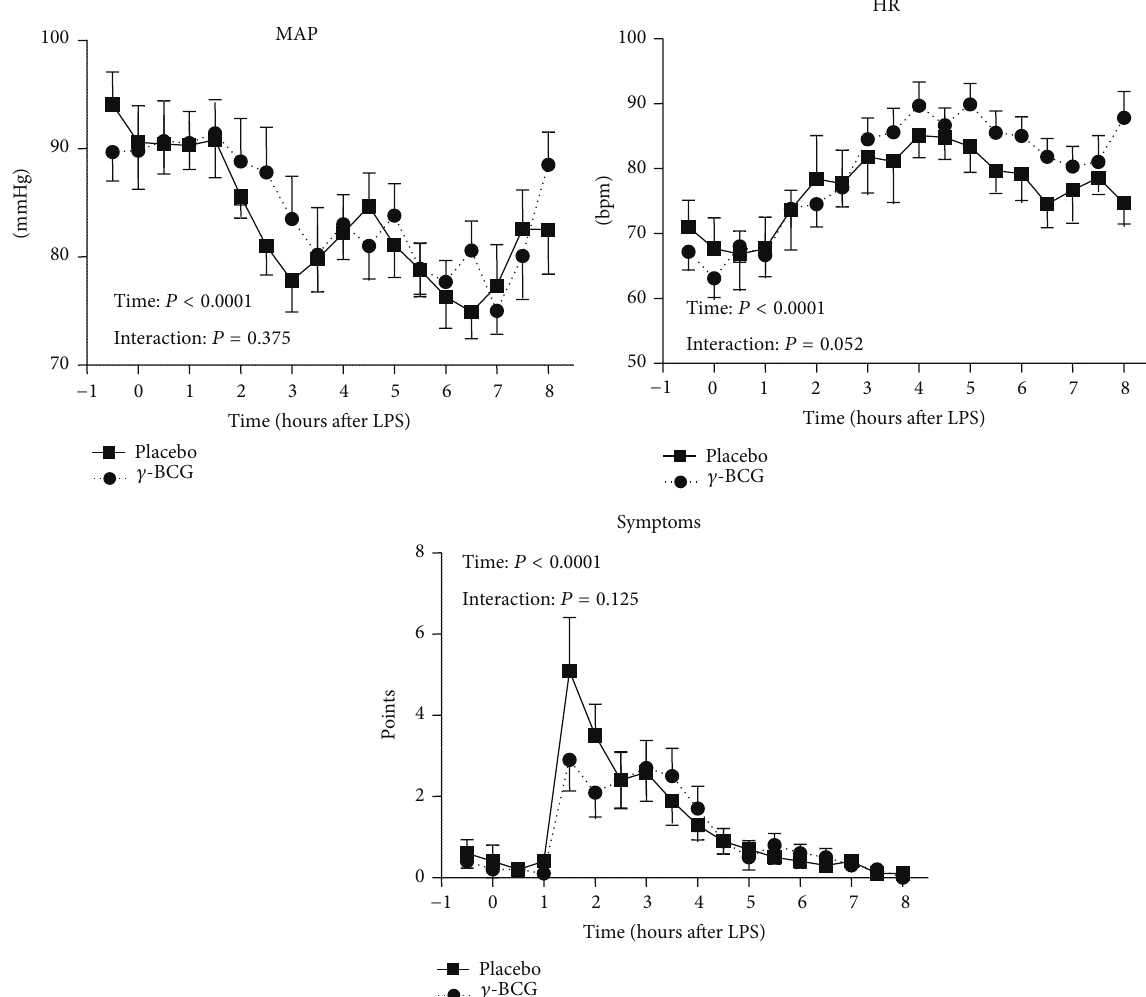
Figure 2: Blood pressure, heart rate, and symptoms during experimental endotoxemia in subjects vaccinated with gamma-irradiated BCG or placebo. Data are expressed as mean ± SEM ( 𝑛 = 10 per group). 𝑃 values calculated using repeated measures two-way analysis of variance (ANOVA, time and interaction terms). MAP: mean arterial pressure; HR: heart rate; bpm: